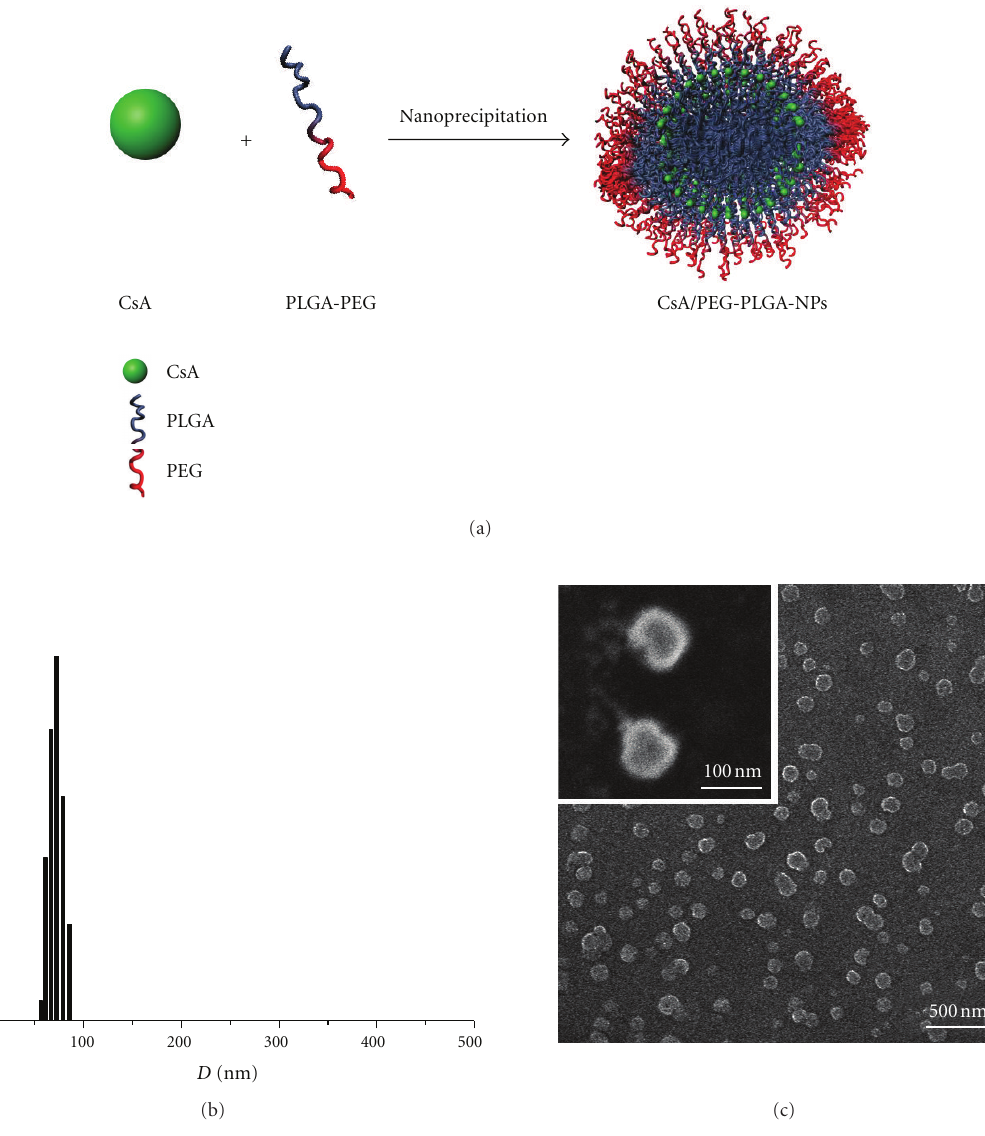
Figure 1: (a) Preparation of CsA/PEG-PLGA-NPs through nanoprecipitation. DLS (b) and SEM (c) characterization of the sizes of the